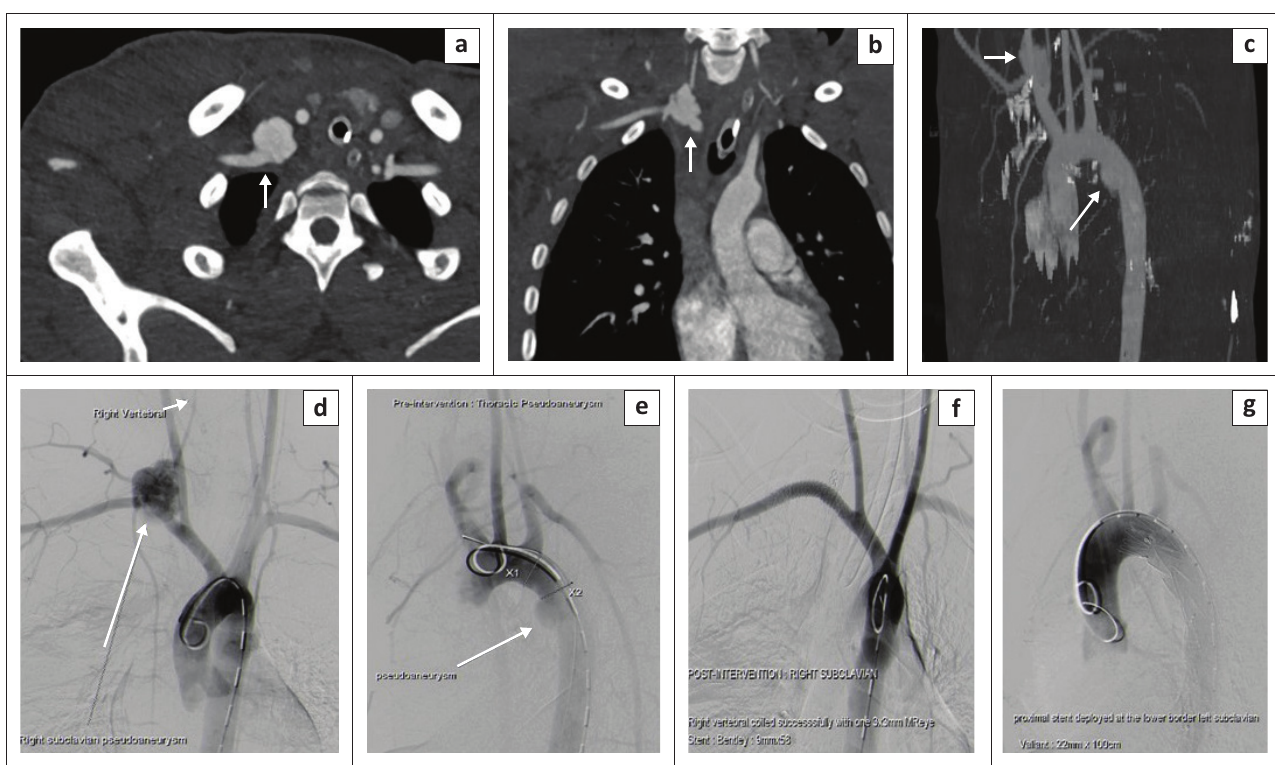
FIG URE 9: Right subclavian artery pseudoaneurysm. Thick arrows in (a), (b) and (c) demonstrate a large lobulated contained contrast extravasation in keeping with subclavian artery pseudoaneurysm, with a surrounding haematoma. The arrow in (c) MIP reformatted image shows an additional aortic pseudoaneurysm (grade III). Images (d) and (e) are pre-intervention planning images, and these were successfully treated with stenting of the right subclavian artery pseudoaneurysm, coiling of the vertebral artery and stenting of the aortic pseudoaneurysm (f) and (g).